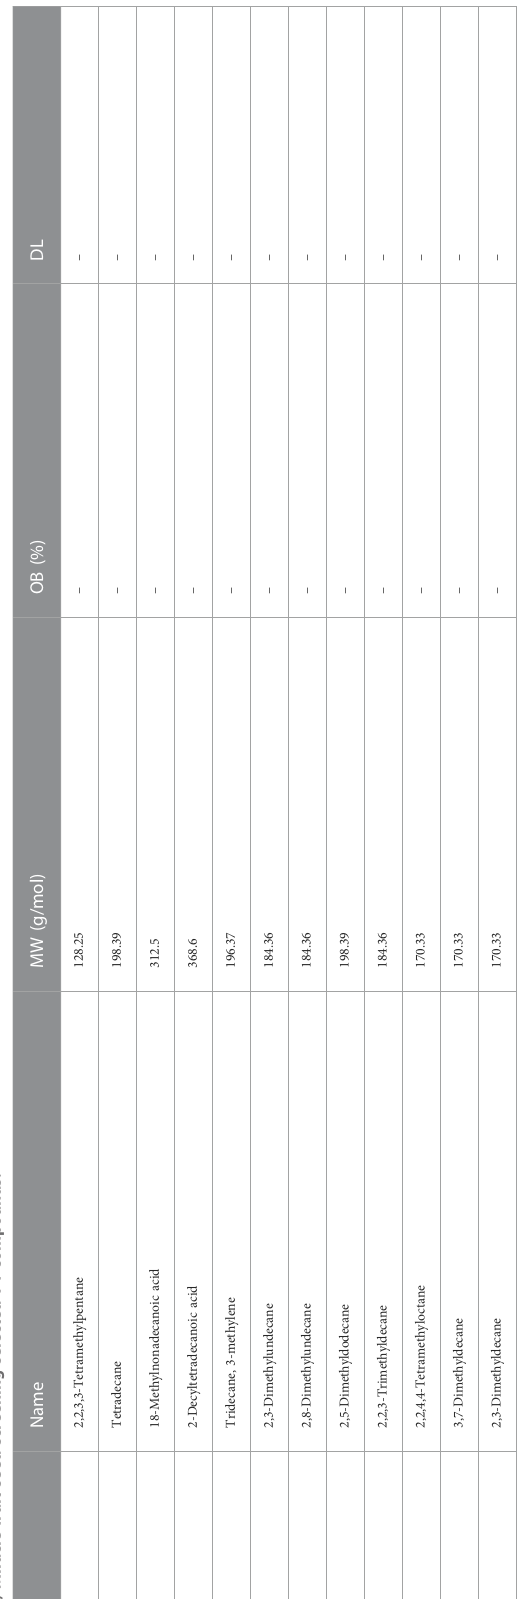
To investigate how the methanolic extract of MFS exhibits its neuroprotective effect on the AD mouse model, Nissl staining was further performed on the mouse brain sections. Also, it was found that the treatment groups treated neuronal damage and neurological de fi cits compared with the untreated control group of the same age (Figure 3A). Compared with the control group, the treatment group retained more total cortical neurons (6 mg/kg vs. control, p = .003; 2 mg/kg vs. control, p < .001, Figure 3B) and fewer dark neurons (6 mg/kg vs. control, p < .001, Figure 3C). As for the hippocampus, the 6 mg/kg treatment group showed more total neurons retention and fewer dark neurons when compared with the control group (total neurons, 6 mg/kg vs. control, p < .001; dark neurons, 6 mg/kg vs. control, p = .043), whereas there was no statistical difference in the 2 mg/kg treatment group (Figures 3D,E, p >